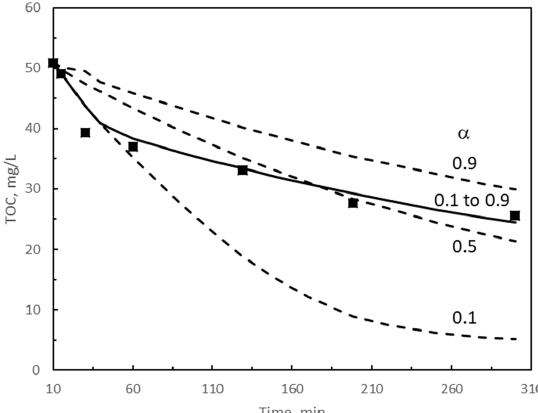
Figure 4. Solution of the kinetic model for single ozonation. Influence of α on TOC changes with time during the second reaction period. k D = 0.5 M − 1 s − 1 . Symbols: experimental results. Dotted and continuous curves: calculated results. Continuous curve: best fitting results with α variable. Other experimental conditions as in Figure 1. Experimental TOC values taken from [30].